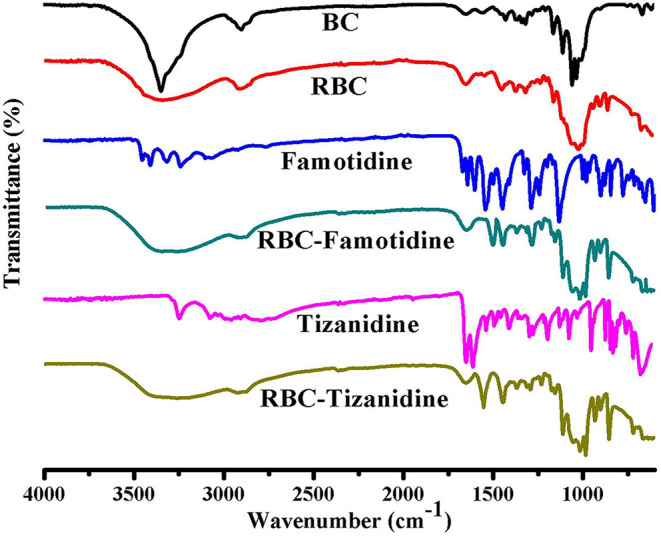
FTIR spectrum of the prepared BC, R-BC, famotidine, R-BC-famotidine, tizanidine, and R-BC-tizanidine matrices for comparison.